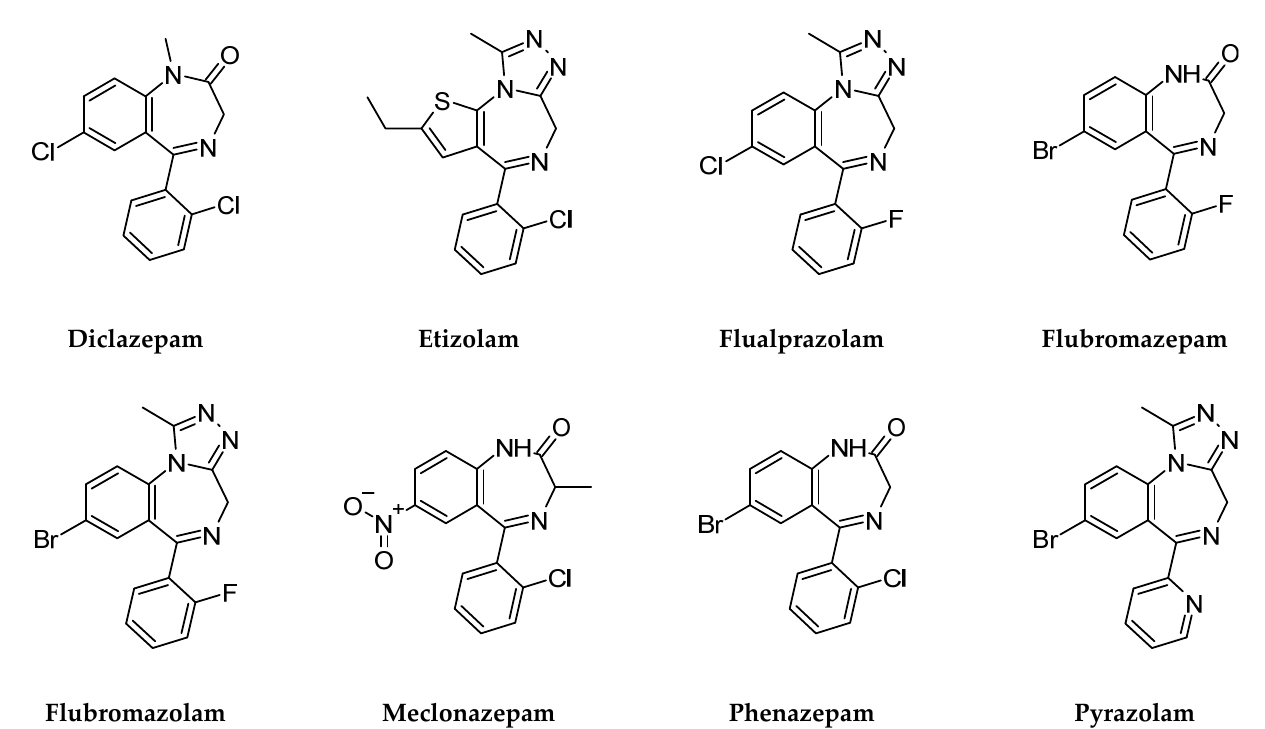
Figure 1. Chemical structure of “designer” benzodiazepines. Most patients and victims were young individuals of both sexes, often with a previous history of substance abuse and mental illness. Acute intoxications and deaths related to DBZD, alone or in combination with other drugs of abuse, were reported in Finland, Germany, Japan, Norway, Poland, Sweden, UK and USA. DBZD were screened using LC-HRMS (LC-QTOF-MS and LC-Orbitrap-MS) and quantified with LC-MS, LC-MS/MS, LC-DAD, GC-MS or